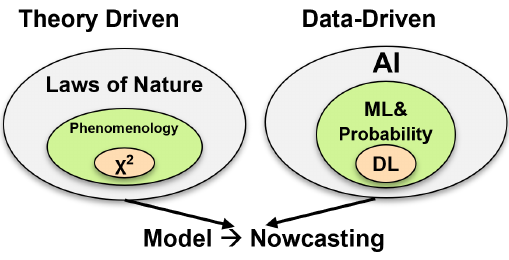
Figure 1. Comparison of traditional theory-driven analysis ( left ) with the data-driven ideas ( right